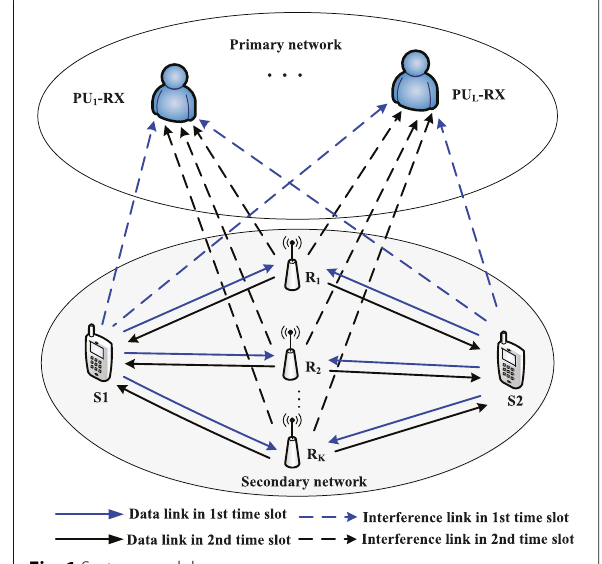
information with the assistance of K half-duplex relay nodes. It is also assumed that all the nodes in this network are equipped with a single antenna and operate in a time division duplexing (TDD) mode. Due to OFDM transmis- sion technique, the channel is divided into N orthogonal subcarriers. We denote the channel coefficients from S 1 and S 2 to the k th , k ∈ [ 1 : K ] relay node on the n th , n ∈ and h n , respectively. Con- [ 1 : N ] subcarrier are h n 1, k 2, k sidering channel reciprocity nature, the duplexing period is smaller than channel coherence time, then the channel coefficients from the k th relay node to S 1 and S 2 on the n th subcarrier are the same as h n and h n 1, k 2, k